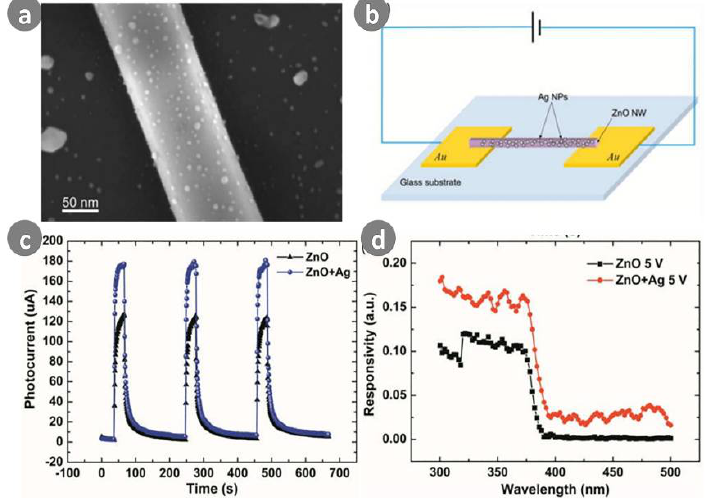
Figure 9. ( a ) Ag nanoparticles on the surface of ZnO nanowire; ( b ) Schematic image of the complete device with double Schottky barrier contacts; ( c ) Time dependence of the photocurrent under multiple on/off cycles; ( d ) Spectral responsivity of the devices with two type of conducting channel at 5 V bias. Ref. [73] Copyright 2016, Royal Society of Chemistry.